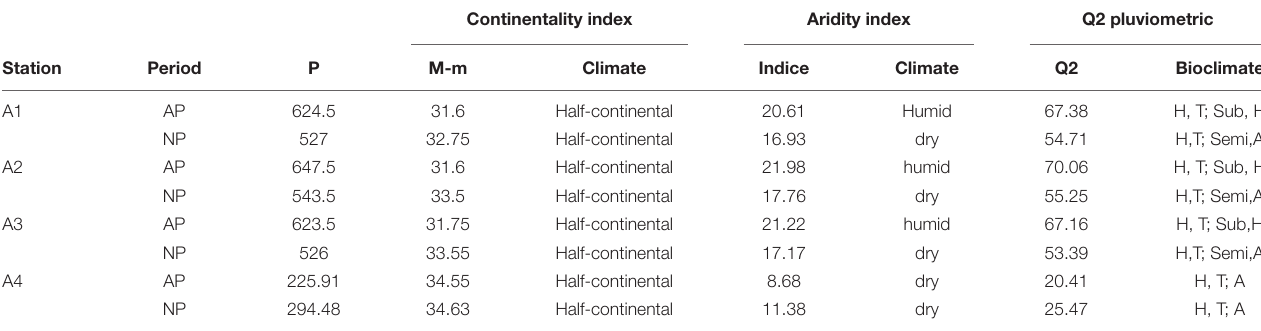
TABLE 3 | Determination of bioclimatic syntheses according to continentality, aridity, and pluviothermic ratio climatic indices in the four stations.